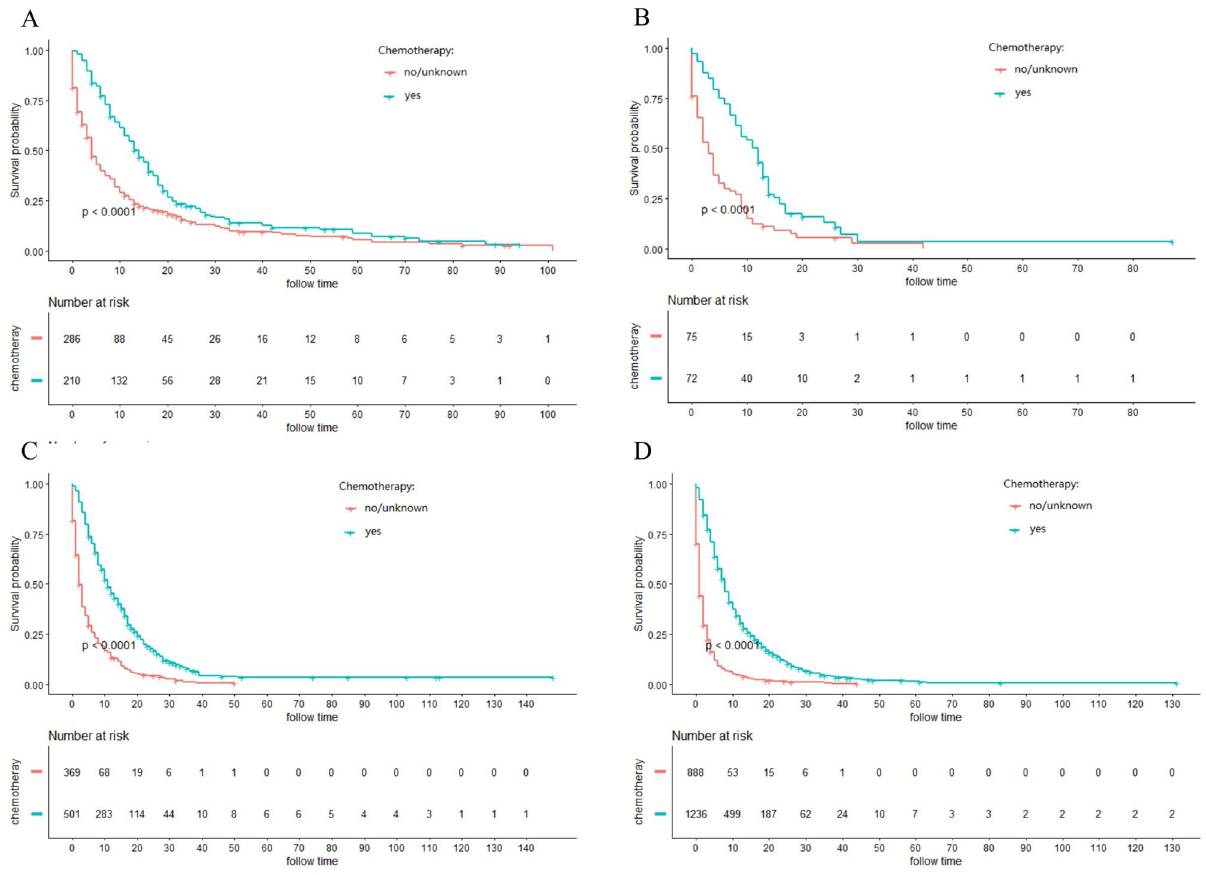
Figure 5. Kaplan–Meier curves for overall survival (OS) in different AJCC stage between chemotherapy and no-chemotherapy groups in unresectable ICC patients: ( A ) stage I; ( B ) stage II; ( C ) stage III; ( D ) stage